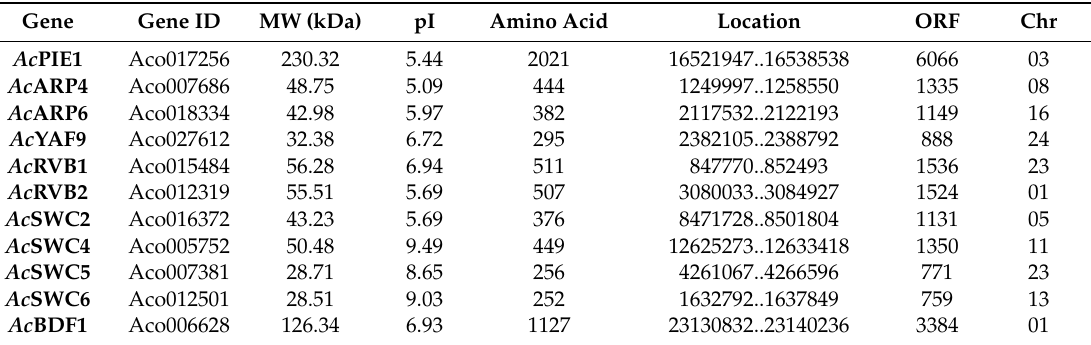
Table 1. Characterization of SWR1-C subunits of pineapple.